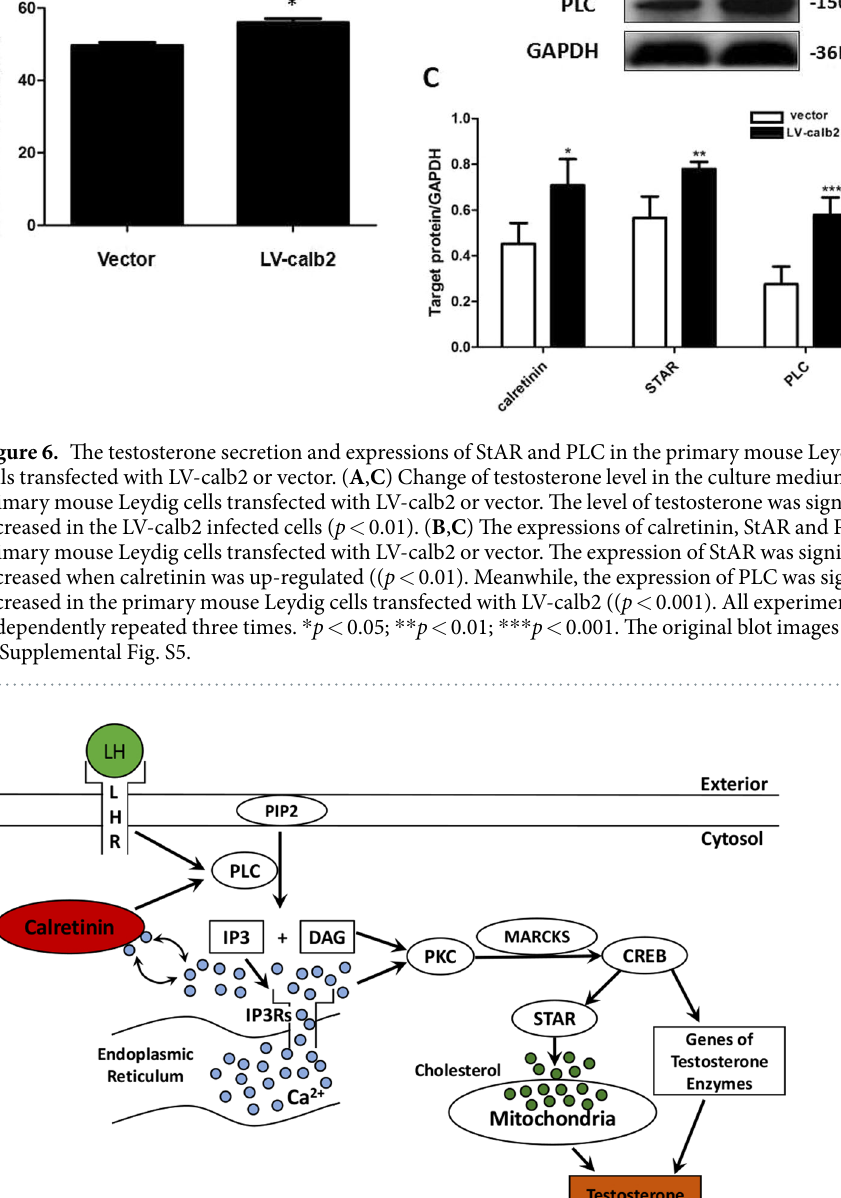
cytoplasm through T-type Ca 2 + channels on the cell membranes; and then through the T-type Ca 2 + channels, Ca 2 + is released from endoplasmic reticulum into the cytoplasm 27 . Endoplasmic reticulum in Leydig cells has two kinds of T-type calcium channels: RyRs and IP3 receptor (IP 3 Rs) 26 . Activation of RyRs is the main regulation of Ca 2 + level, however how RyRs is activated by LH remains unclear. It is well known that LH can activate the PLC, crack PIP2 into IP3 and DAG 28 , as showed in Fig. 7. IP3 combining with IP3Rs can activate Ca 2 + channels in endoplasmic reticulum 29 , so as to increase cytoplasmic level of Ca 2 + . Calretinin in the cytoplasm can bind